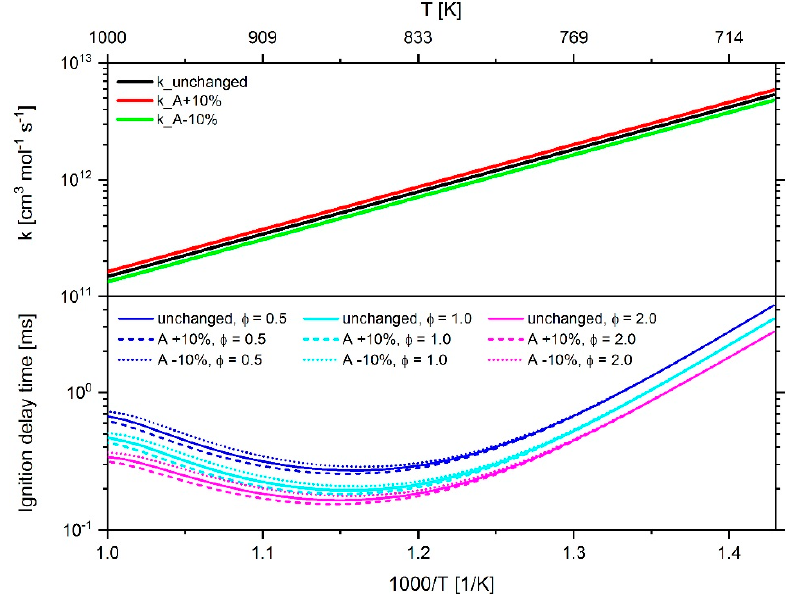
Figure 21. Effect of adjusting the frequency factor 𝐴 of reaction 299 by ±10% on the reaction rate constant k and the IDT simulated with an n -heptane–air mixture at 60 bar and a fuel–air equivalence ratio of 0.5, 1.0 and 2.0.